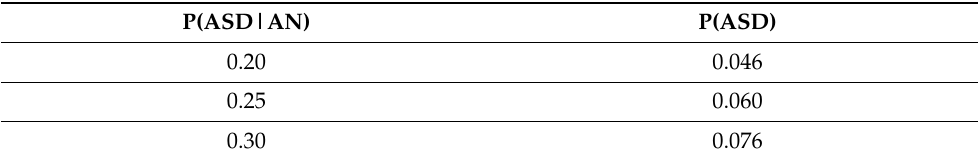
Table 6. P(ASD) for 95% range of hazard ratio with P(ASD|AN) of 0.25.